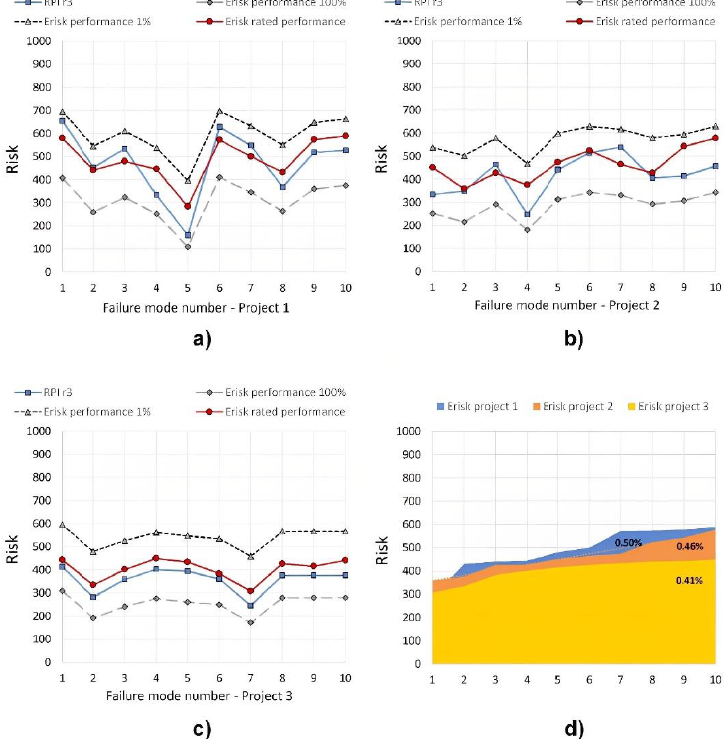
Figure 9. Case 2, risk results considering the weights QMI 0.30, Severity 0.4, Occurrence 0.2, Detectability 0.1. ( a ) project 1 results, ( b ) project 2 results, ( c ) project 3 results, ( d ) effective risk for projects 1, 2, and 3 considering the weights of Case 2.